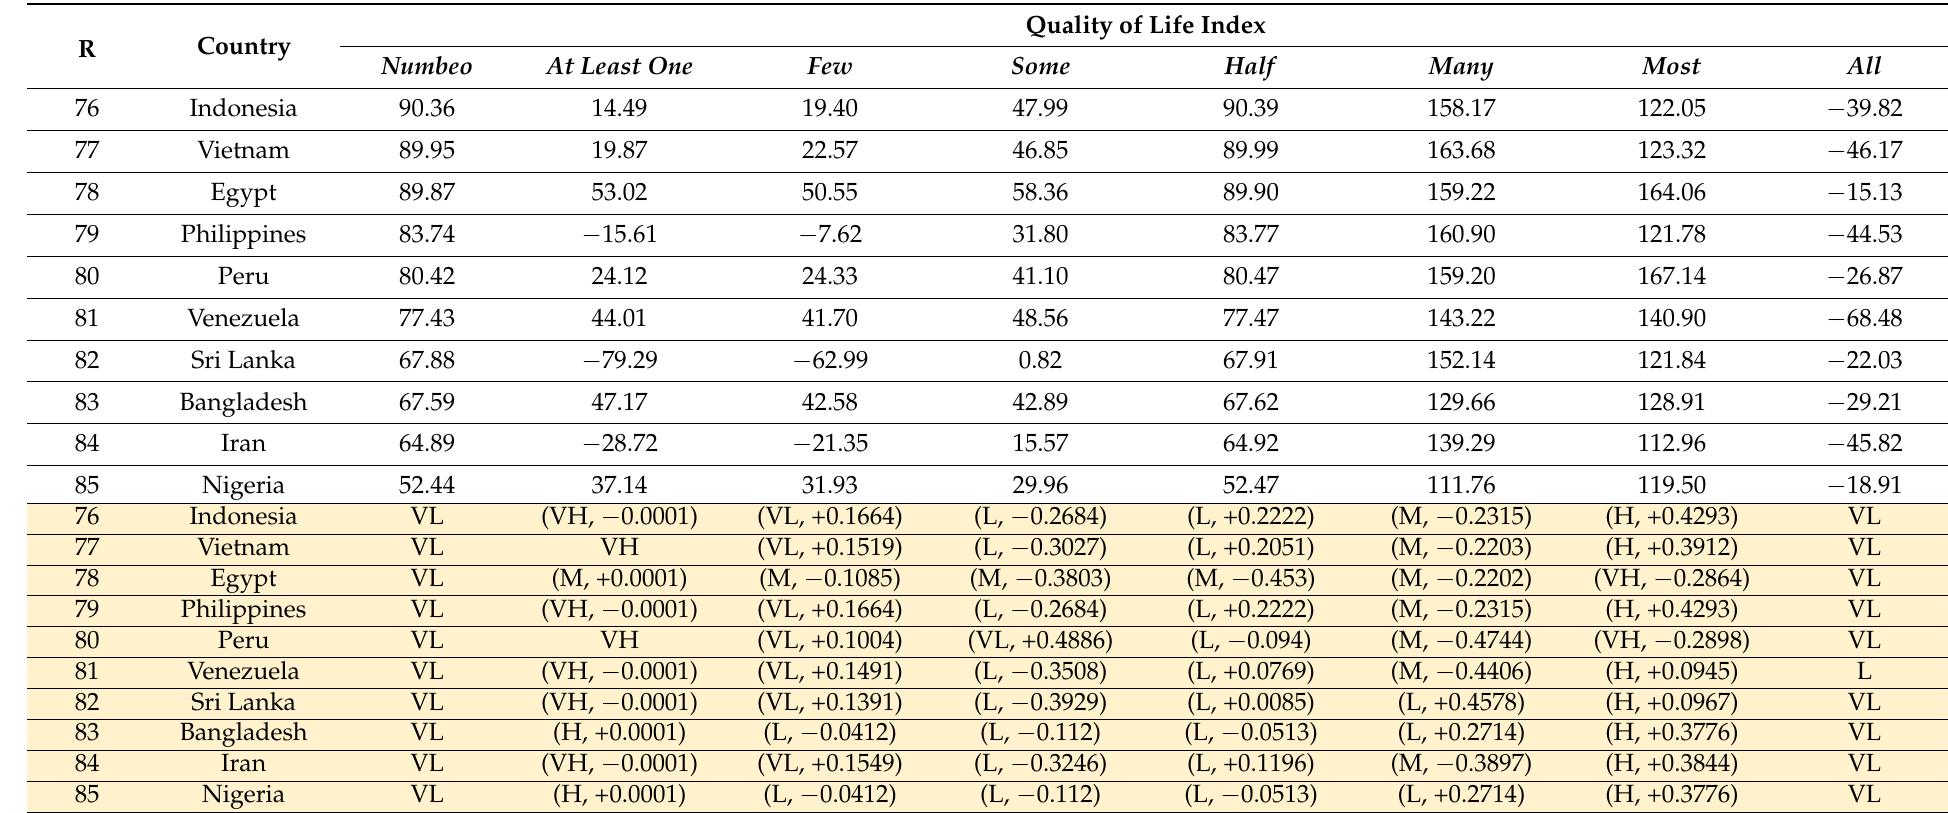
Table 8. Numbeo worst 10 countries in terms of quality of life index (number versus. 2-tuple